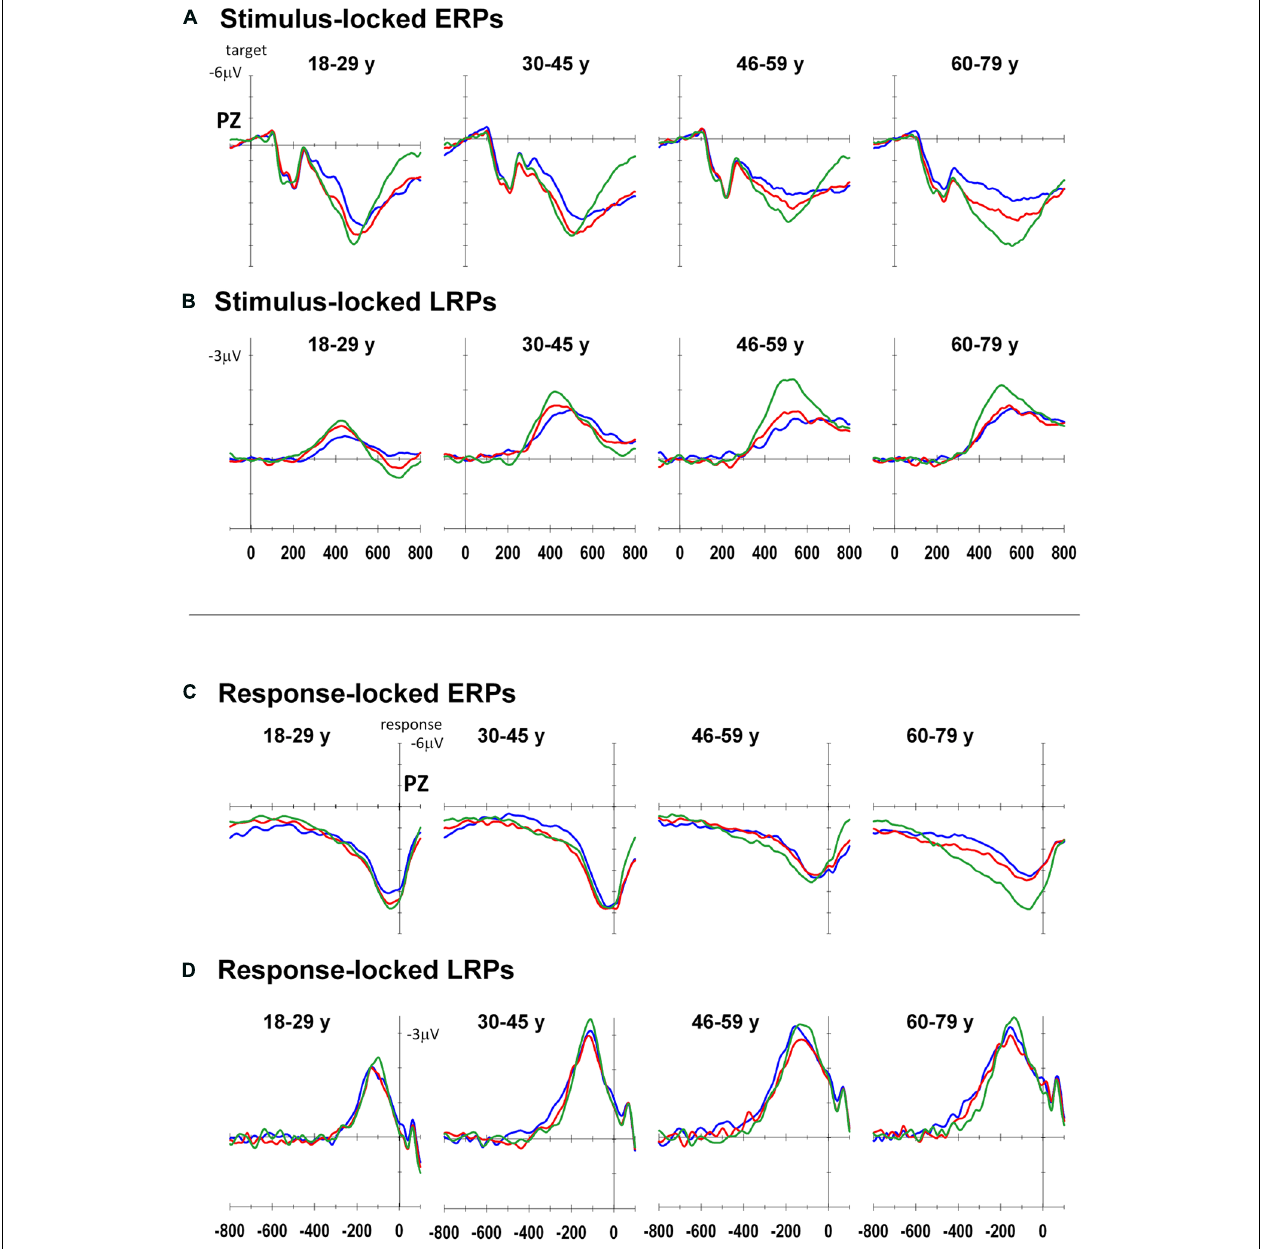
FIGURE 3 | Event-related potentials for each age group: Stimulus-locked ERP (A) and LRP (B), response-locked ERP (C) and LRP (D) for all-repeat (green), mixed-repeat (red), and switch (blue)